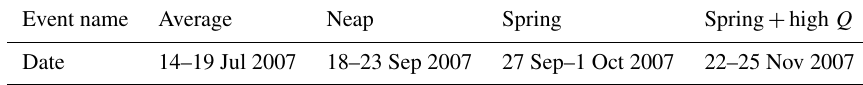
Table 2. Tidal events used for validation and dates of occurrence.